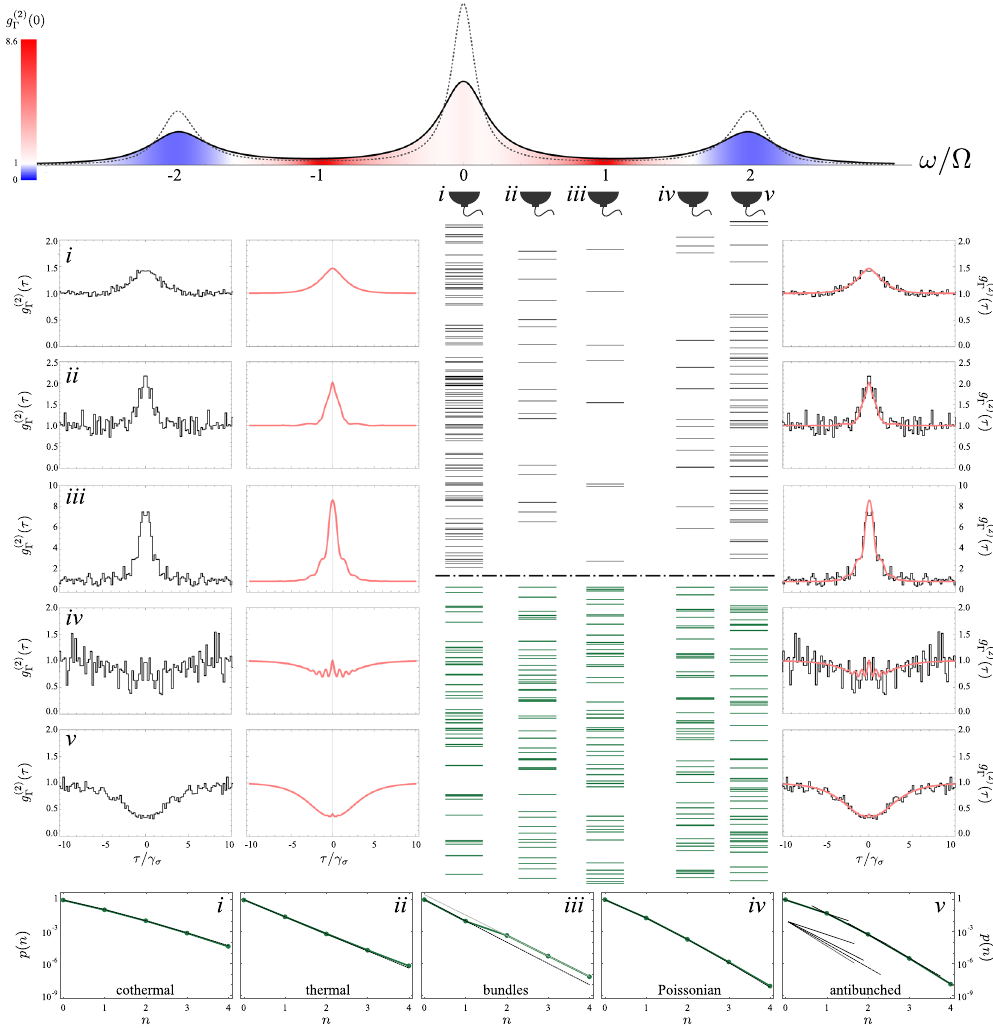
Figure 7. Frequency-resolved Monte Carlo simulation of the Mollow triplet in independent frequency windows. The dotted (solid) lineshape is the triplet as detected by an ideal (finite-bandwidth Γ ) detector. Sequences of clicks in the frequency windows i – v have been recorded, with 17241, 22836, 99457, 9112 and 46126 events, respectively. Small samples are displayed, in the same time window (black ticks, up) or with renormalization of time to compare equal intensities (green ticks, bottom). Clear structures are visible even to the naked eye, in particular, the existence of leapfrog emission is obvious. Only one detector has been used, so the streams are not here cross-correlated. The autocorrelations are shown as measured by the Monte Carlo data (left column), as computed by the theory of frequency-resolved photon correlation (2nd column, red) and both superimposed (right column), to show their rich fine structure and the overall agreement. The effective quantum state reconstruction is shown at the bottom, together with fits to fundamental distributions. Panel v has its successive emission probabilities brought together to show the exponential extinction of higher photon- numbers. 1/ γ σ sets the unit, Ω = 5 γ σ and Γ = γ σ . The clicks correspond to the emission events of the operators c 4 and c 5 in Eq.